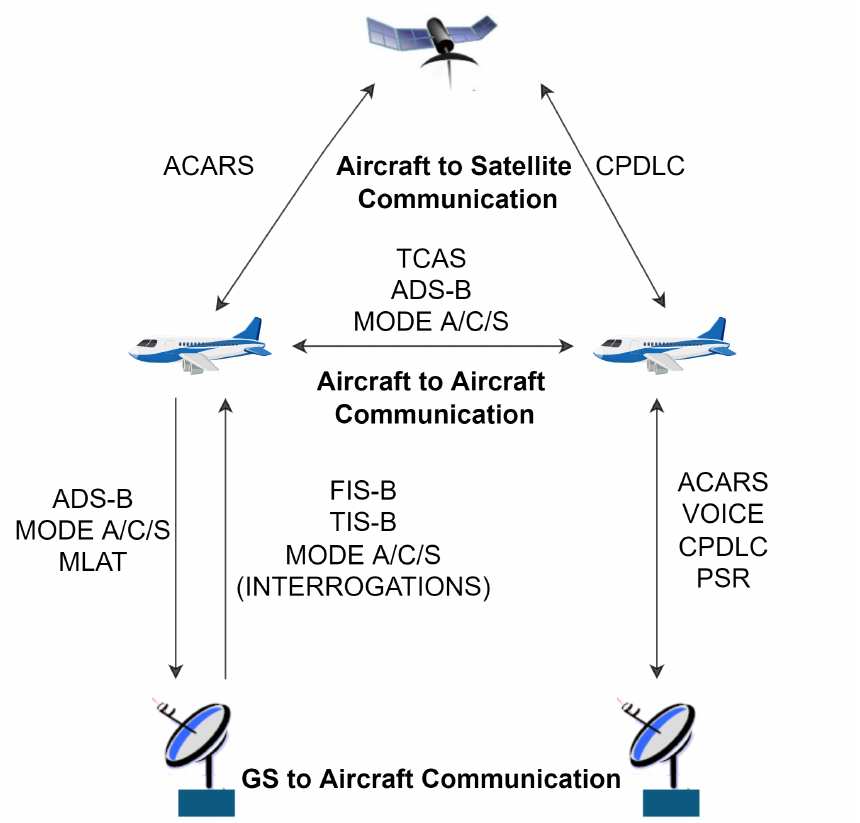
Figure 1. Aircraft Communication Wireless